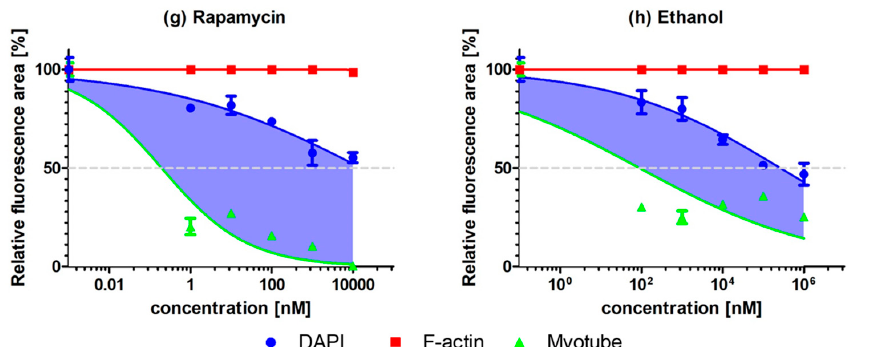
Figure 4. Dose-response curves of eight drugs based on relative fluorescence area of green (MF20), red (F-actin), and blue (Nuclei). ( a ) Sorafenib. ( b ) Regorafenib. ( c ) Lenvatinib. ( d ) Doxorubicin. ( e ) Cabozantinib. ( f ) 5-FU. ( g ) Rapamycin. ( h ) Ethanol.